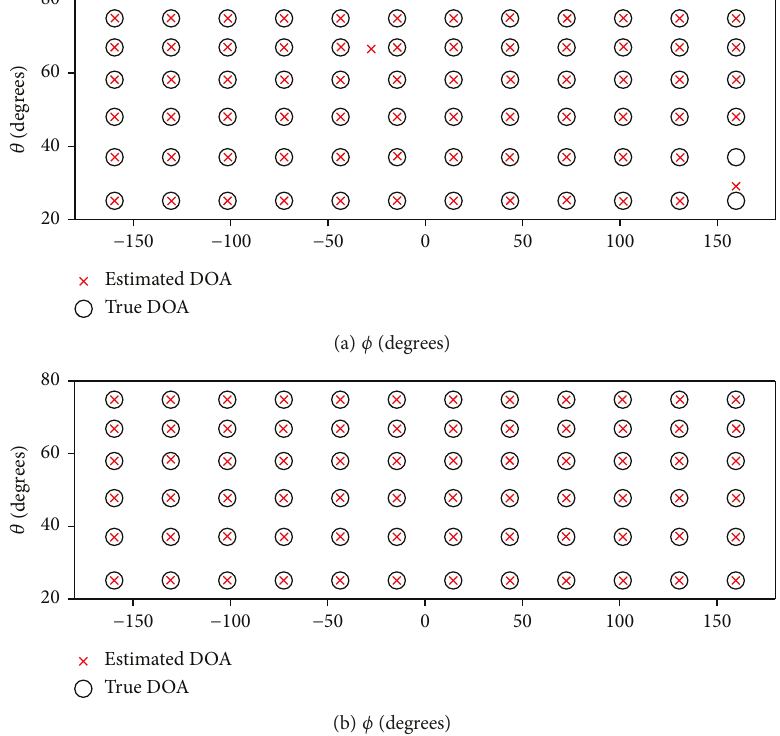
Figure 3: DOA estimations in the presence of mutual coupling of (a) the hourglass array and (b) the thermos